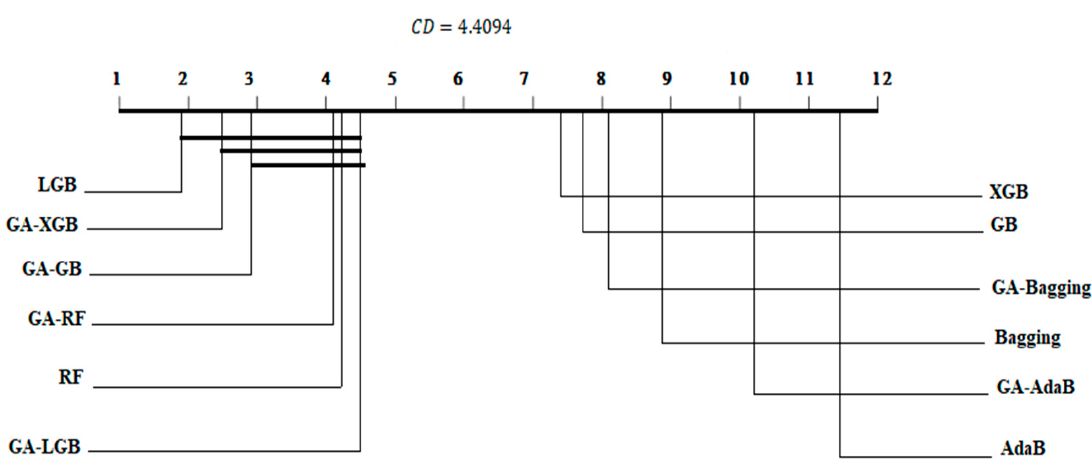
Figure 10. Critical difference diagram of Dataset 2 for the Nemenyi test.